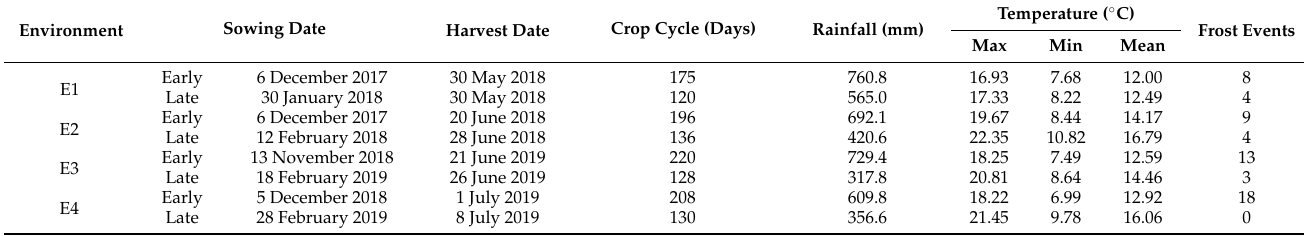
Table 3. Sowing date, seasonal rainfall, and mean daily maximum, minimum, and mean temperatures, as well as number of frost events at the experimental